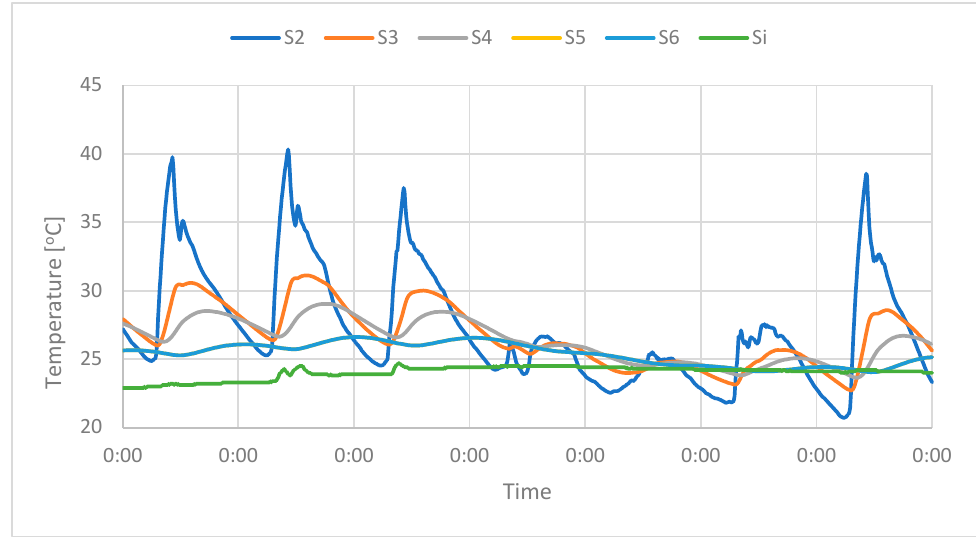
Figure 10. Recorded temperatures in the wall for summer week.